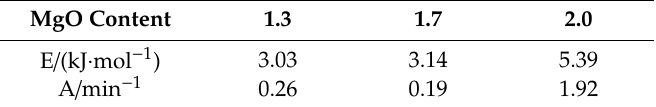
Figure 14. Photos during melting temperature. Table 7. Chemical component at T S (mass fraction) [%]. MgO content